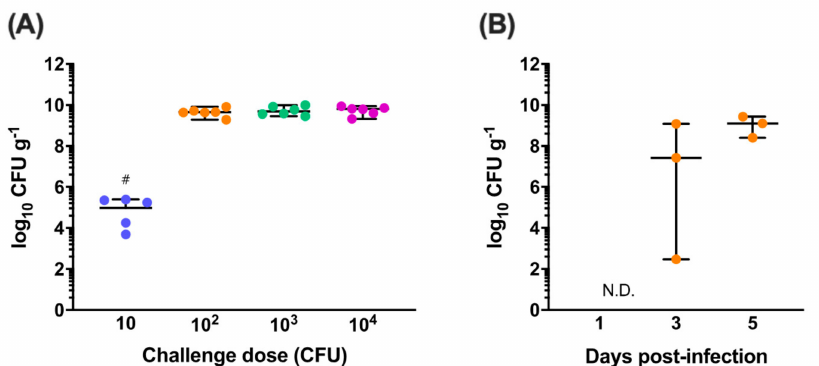
Figure 1. Dose titration and colonisation dynamics of C. jejuni M1. ( A ) White Leghorn chickens were orally challenged with doses of C. jejuni M1 ranging from 10 to 10 4 colony-forming units (CFU) and caecal colonisation was determined at 7 days post-infection. In the group challenged with 10 CFU ( • ), five of the six chickens were colonised at a median level of 4.9 log 10 CFU g − 1 . C. jejuni could not be detected in one chick in this group (#). All chickens challenged with 10 2 CFU ( • ), 10 3 CFU ( • ) and 10 4 CFU ( • ) were colonised at a median level of over 9.6 log 10 CFU g − 1 . A dose of 10 2 CFU was defined as the minimum dose for reliable colonisation. ( B ) The caecal colonisation dynamics of C. jejuni M1 were determined following a challenge with 10 2 CFU ( • ). It was observed that bacterial load increased exponentially over time, reaching a near-maximum median load of 9.1 log 10 CFU g − 1 .